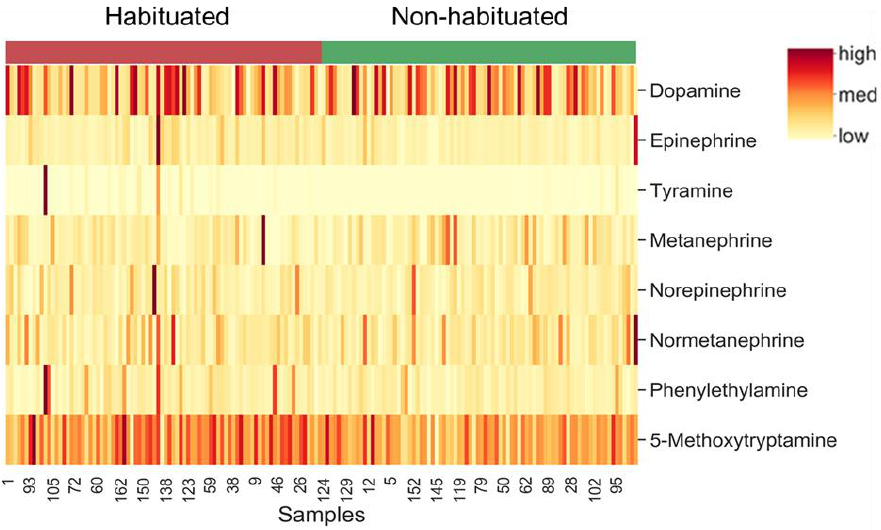
Figure 3. Heat map of plasma catecholamines clustered by treatment (H = Habituated; NH = Non- habituated; p < 0.05).